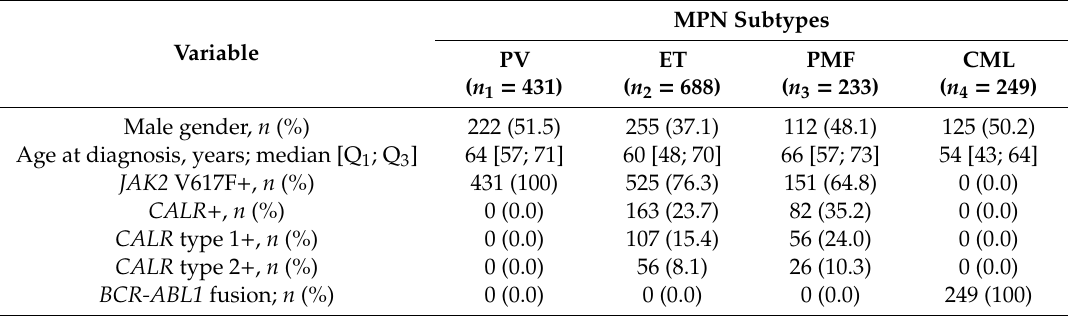
Table 1. Distribution of demographic characteristics and phenotypic driver mutations in MPN patient